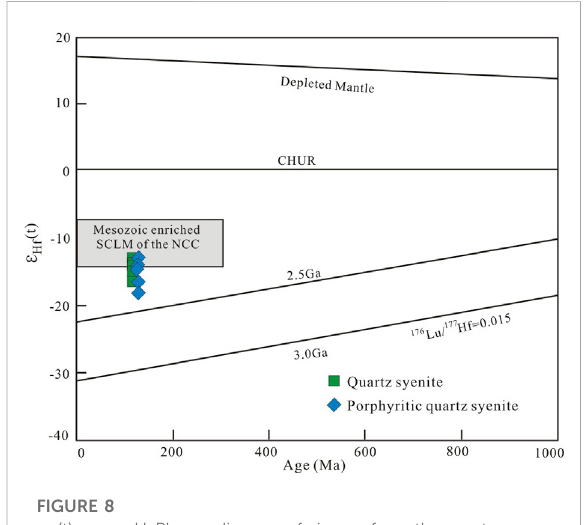
FIGURE 8 ε Hf (t) versus U-Pb age diagram of zircons from the quartz syenite at the Chishan and Longbaoshan complexes. (Data for the enriched NCC mantle are from Yang et al., 2006; Lan et al.,